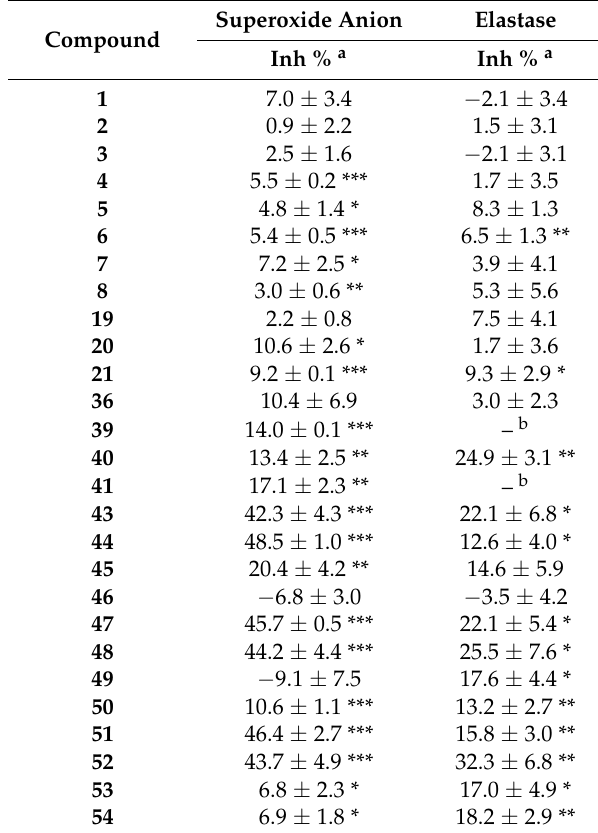
Table 2. Superoxide anion and elastase inhibitory effects of isolated compounds in human neutrophils.